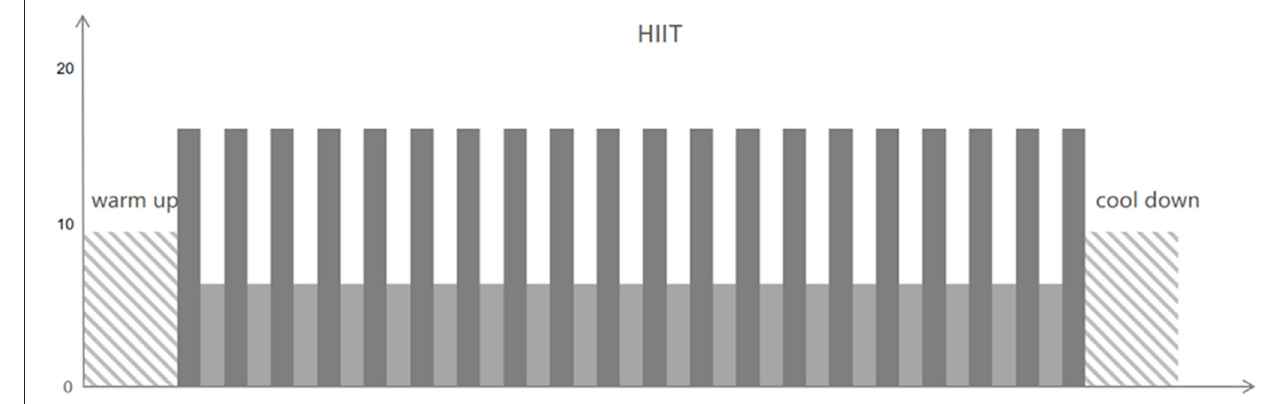
FIGURE 2 | High-intensity interval training (HIIT).